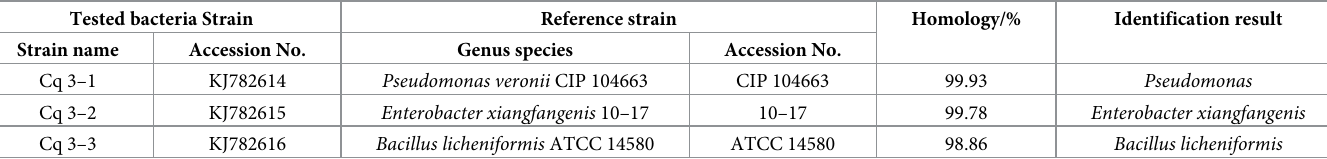
Table 4. Blast result of the tested bacteria strains 0 16S rDNA. Tested bacteria Strain